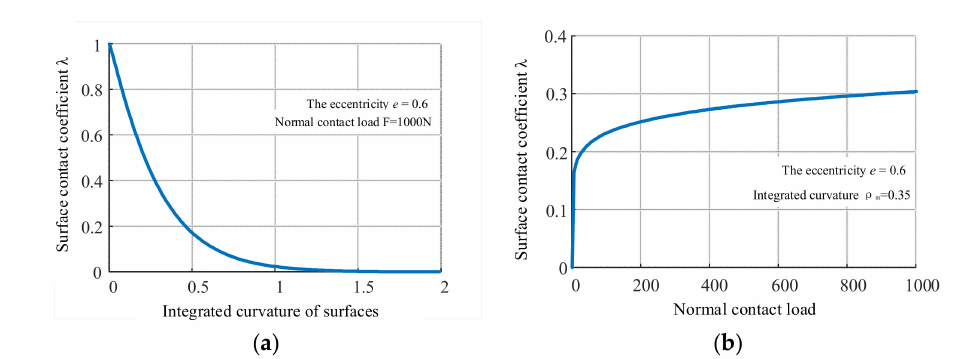
Figure 8. Fractal characterization of rough surfaces with different processing texture features: ( a ) G x = 1.0 × 10 − 11 m, G y = 1.0 × 10 − 9 m, D x = 1.6, D y = 1.3; ( b ) G x = 1.0 × 10 − 9 m, G y = 1.0 × 10 − 11 m, D x = 1.3, D y =